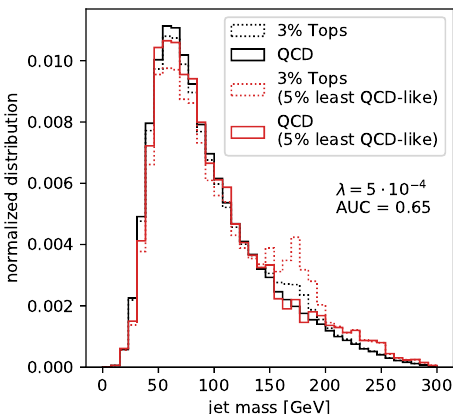
Figure 7: Jet mass distributions from the adversarial autoencoder trained on a mixed sample with 3% top jets using λ = 5 · 10 − 4 , and tested on a QCD sample or on the same mixed